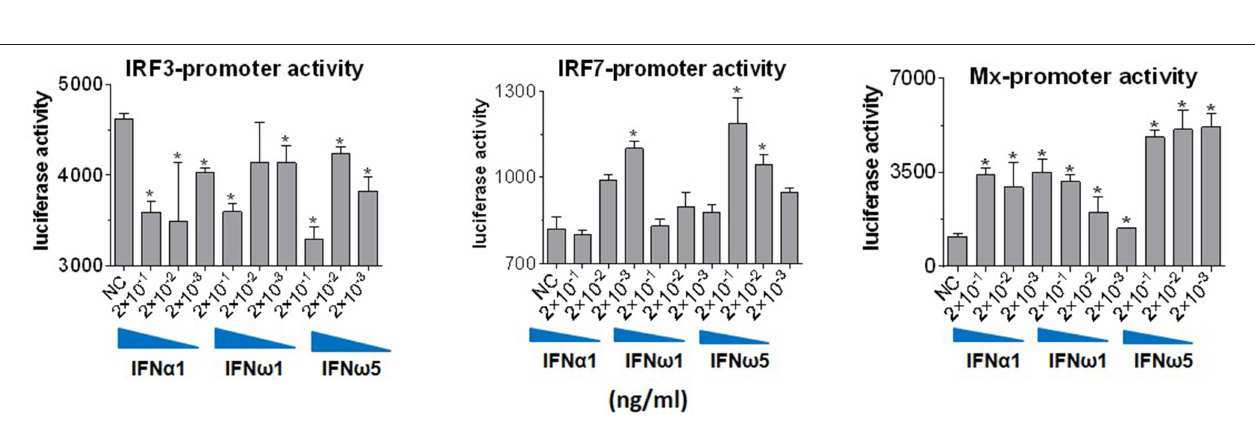
FIGURE 8 | IFN comparative activity bioassay in MARC-145 cells that stably transformed with an IFN-regulatory factor (IRF)3-, IRF7-, or a myxovirus resistance gene 1 (Mx1)-promoter driven luciferase reporter system. MARC-145 cells that were transformed with the promoter-reporter constructs were treated with IFN peptides at indicated concentrations for 24h, lysed with Glo lysis buffer and quantified by Steady-Glo ® Luciferase Assay System (Promega) (13, 24). Data are means ± SE; n = 3; * p < 0.05 relative to the control.